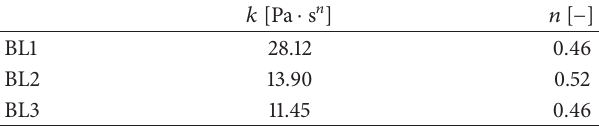
Table 3: Parameters of the power law model.